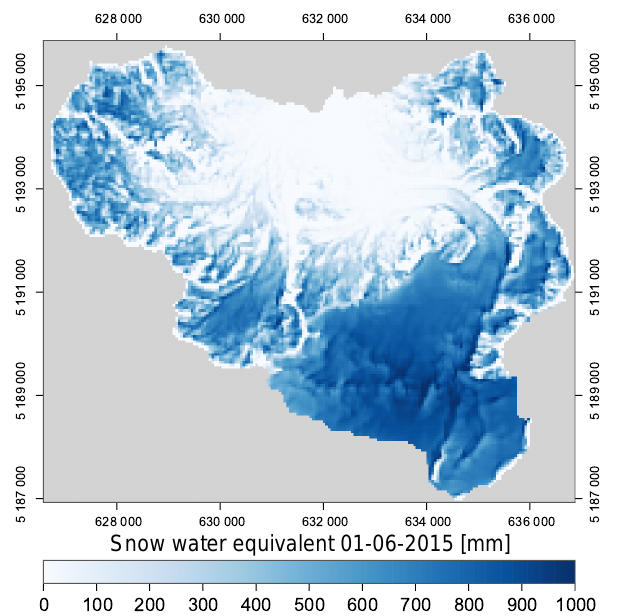
Figure 5. Areal initial values of snow water equivalent (SWE) pro- vided by AMUNDSEN for 1 June 2015.